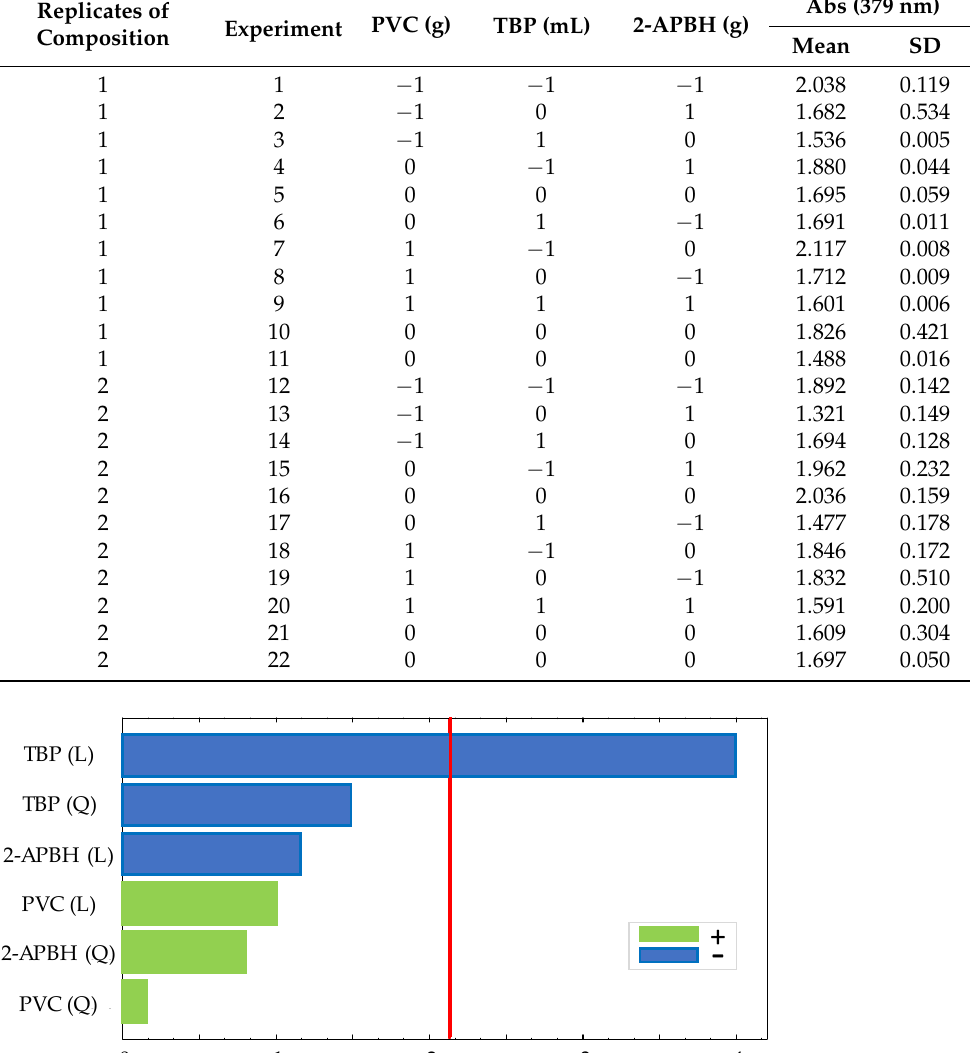
Table 2. Matrix of the 3 3 − 1 experimental design (22 runs; n = 2) and response of the optical sensor exposed to 1 mg L − 1 of Cd(II) at pH 9 (n = 2).